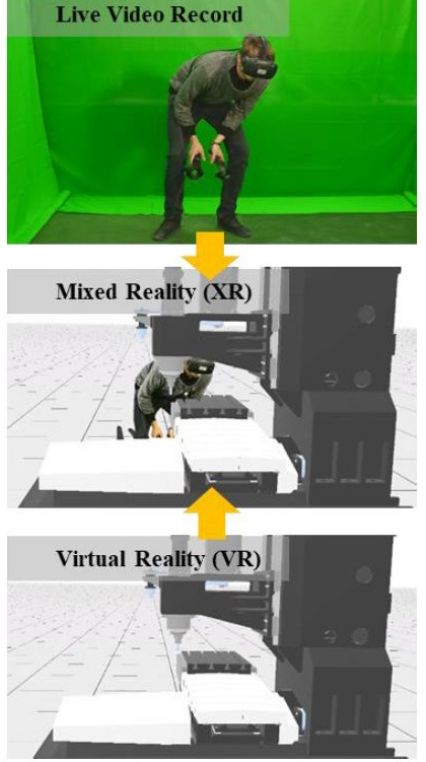
Figure 4. Creation of an XR video stream [6] (p. 7).